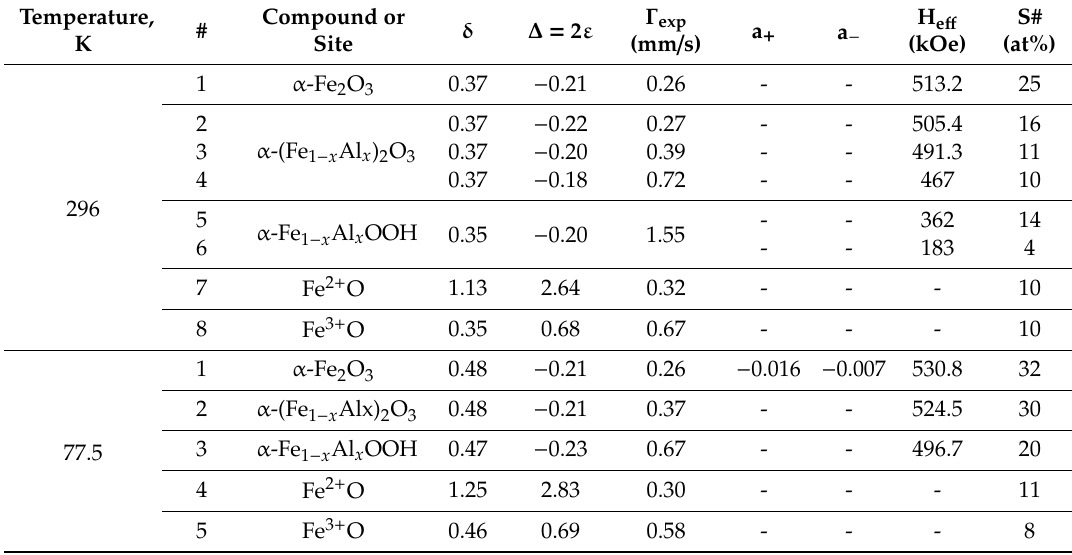
Table 2. Mössbauer spectra parameters of red RM obtained at 296 and 77.5